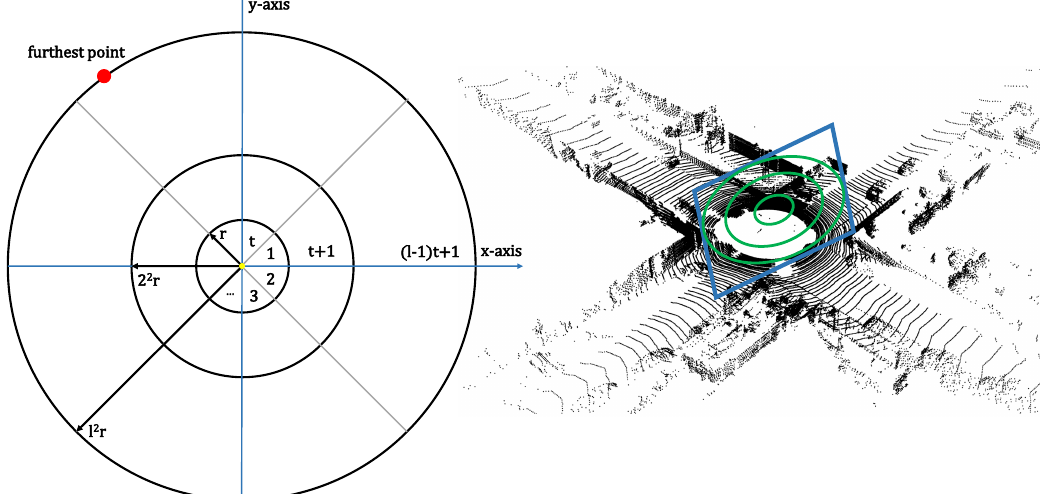
Figure 2. The generation of a 2D signature by projecting the 3D data onto a plane. The plane is divided into bins as follows: starting from the projected centroid, l concentric circles are generated and the maximum radius is set to the distance between the centroid and the furthest point. Each ring is subsequently subdivided into t bins, generating a lt × 1 signature vector. Finally, the number of points lying in each bin are